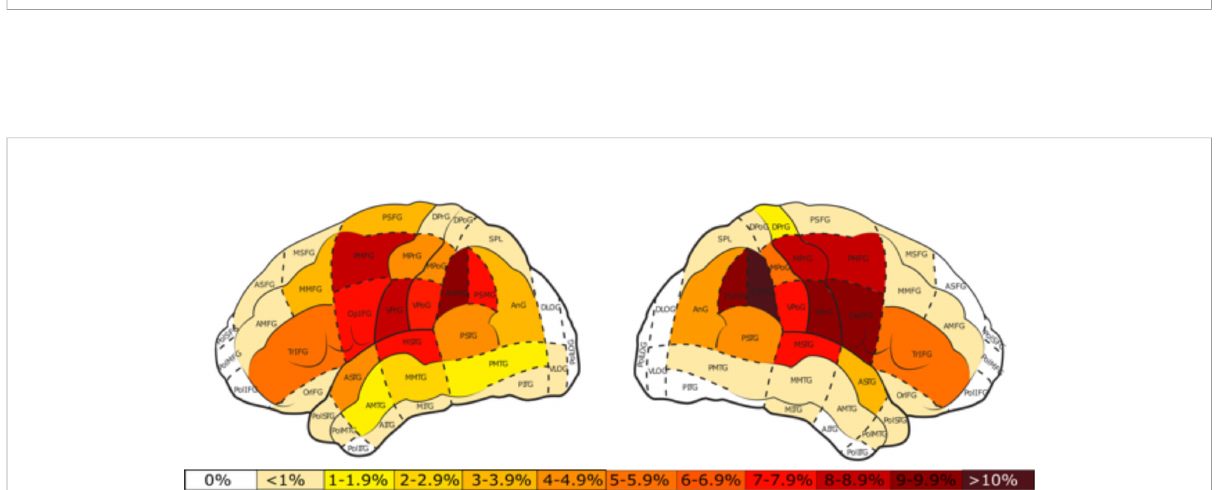
FIGURE 5 Percentage of total stimulations per cortical area for the perisylvian protocol in the left and right hemisphere. White areas represent those in which no stimulations took place. The color bar represents the percent distribution ranging from 0% (white) to >10% (dark